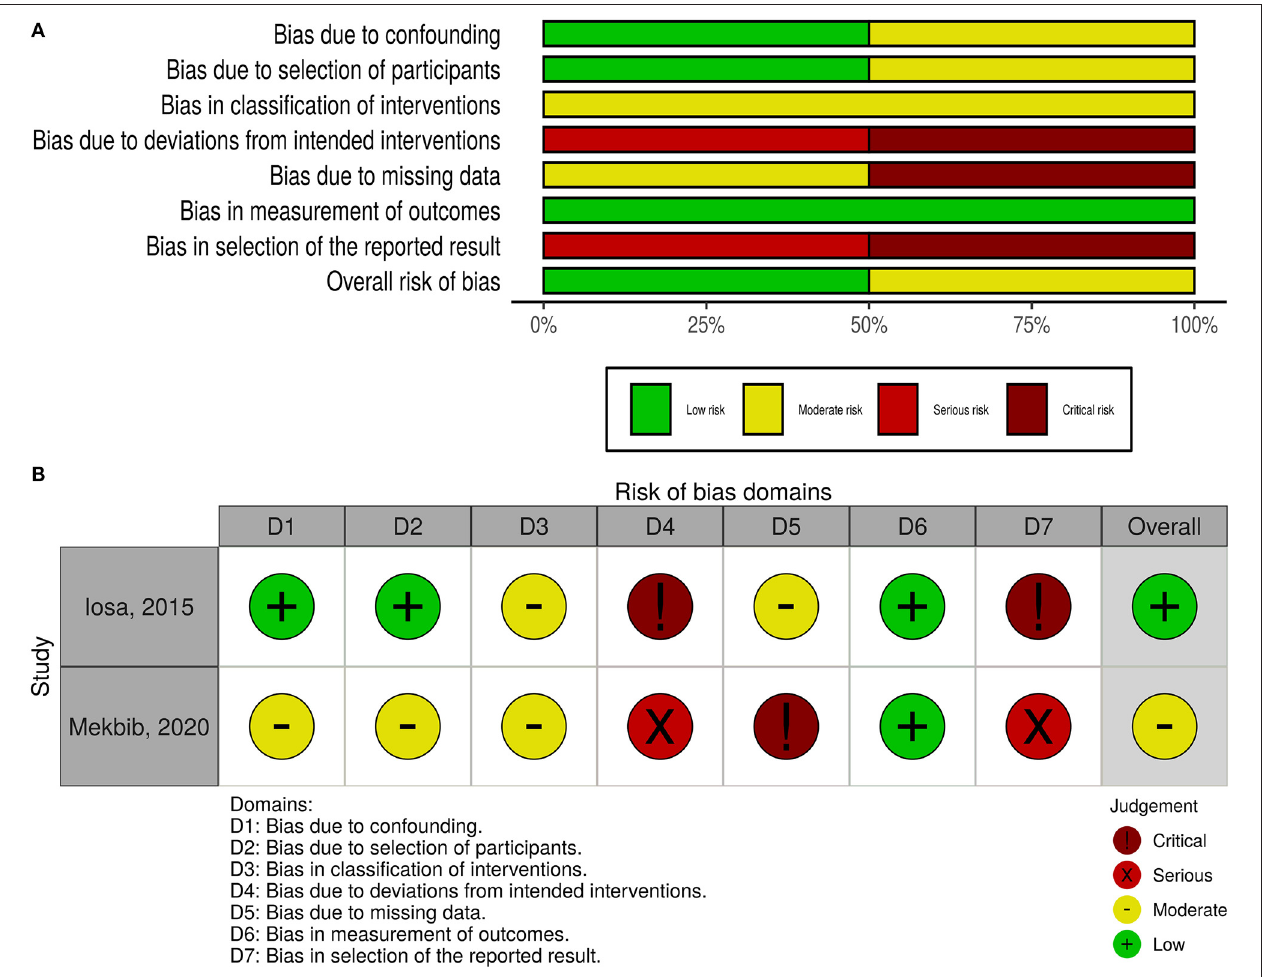
FIGURE 3 | Quality of the included non-randomized controlled trials. (A) Risk-of-bias graph: review authors’ judgments about each risk-of-bias item presented as percentages across all included studies. (B) Risk-of-bias summary: review authors’ judgments about each risk-of-bias item for each included